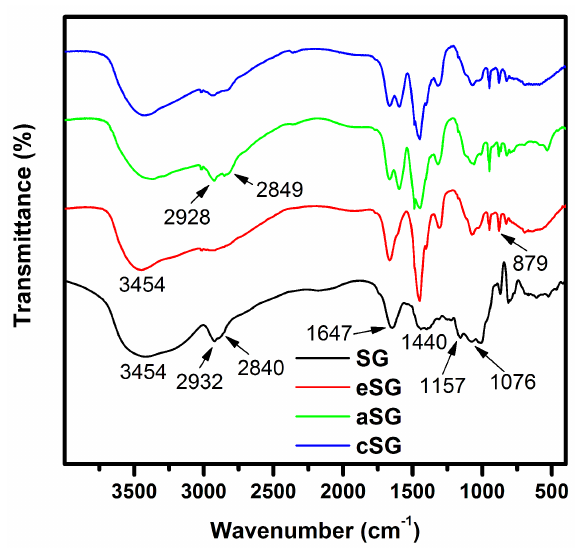
Figure 2. FTIR spectra of SG, eSG, aSG, and cSG.